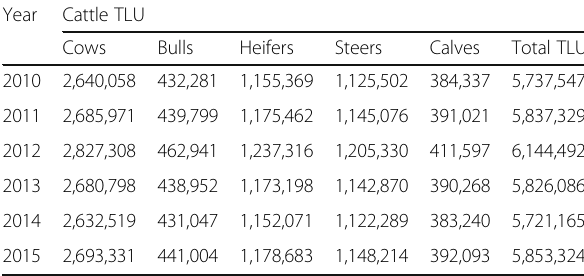
Milk production in pastoral systems